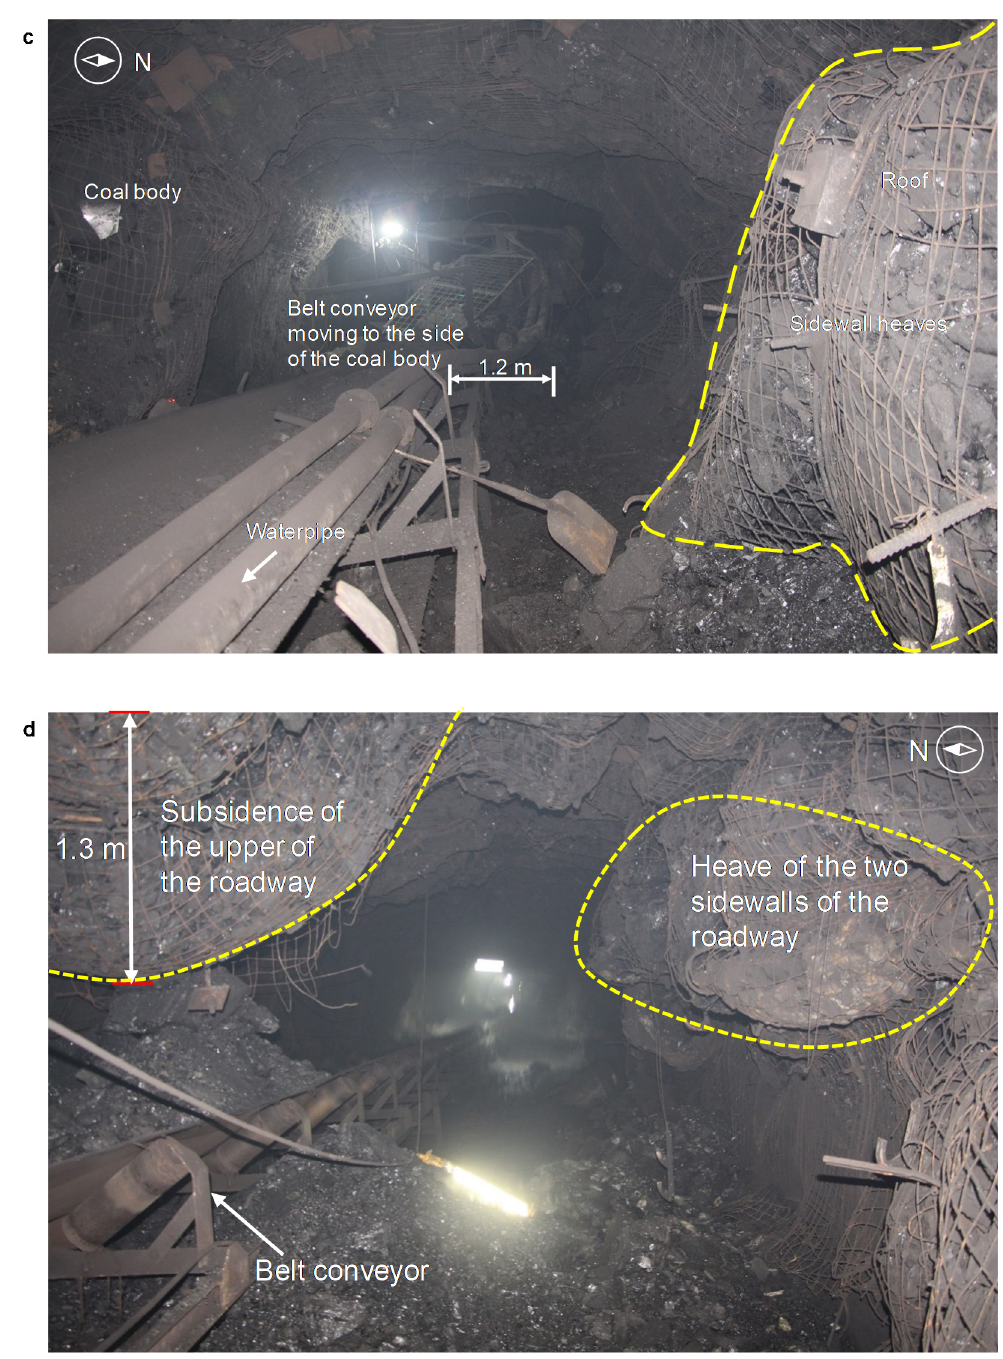
Figure 4. Damage caused by the rockburst: ( a ) floor heave; ( b ) sidewall heave; ( c ) belt conveyor moving to the side of the coal body and sidewall heave; ( d ) subsidence of the upper part of the roadway.